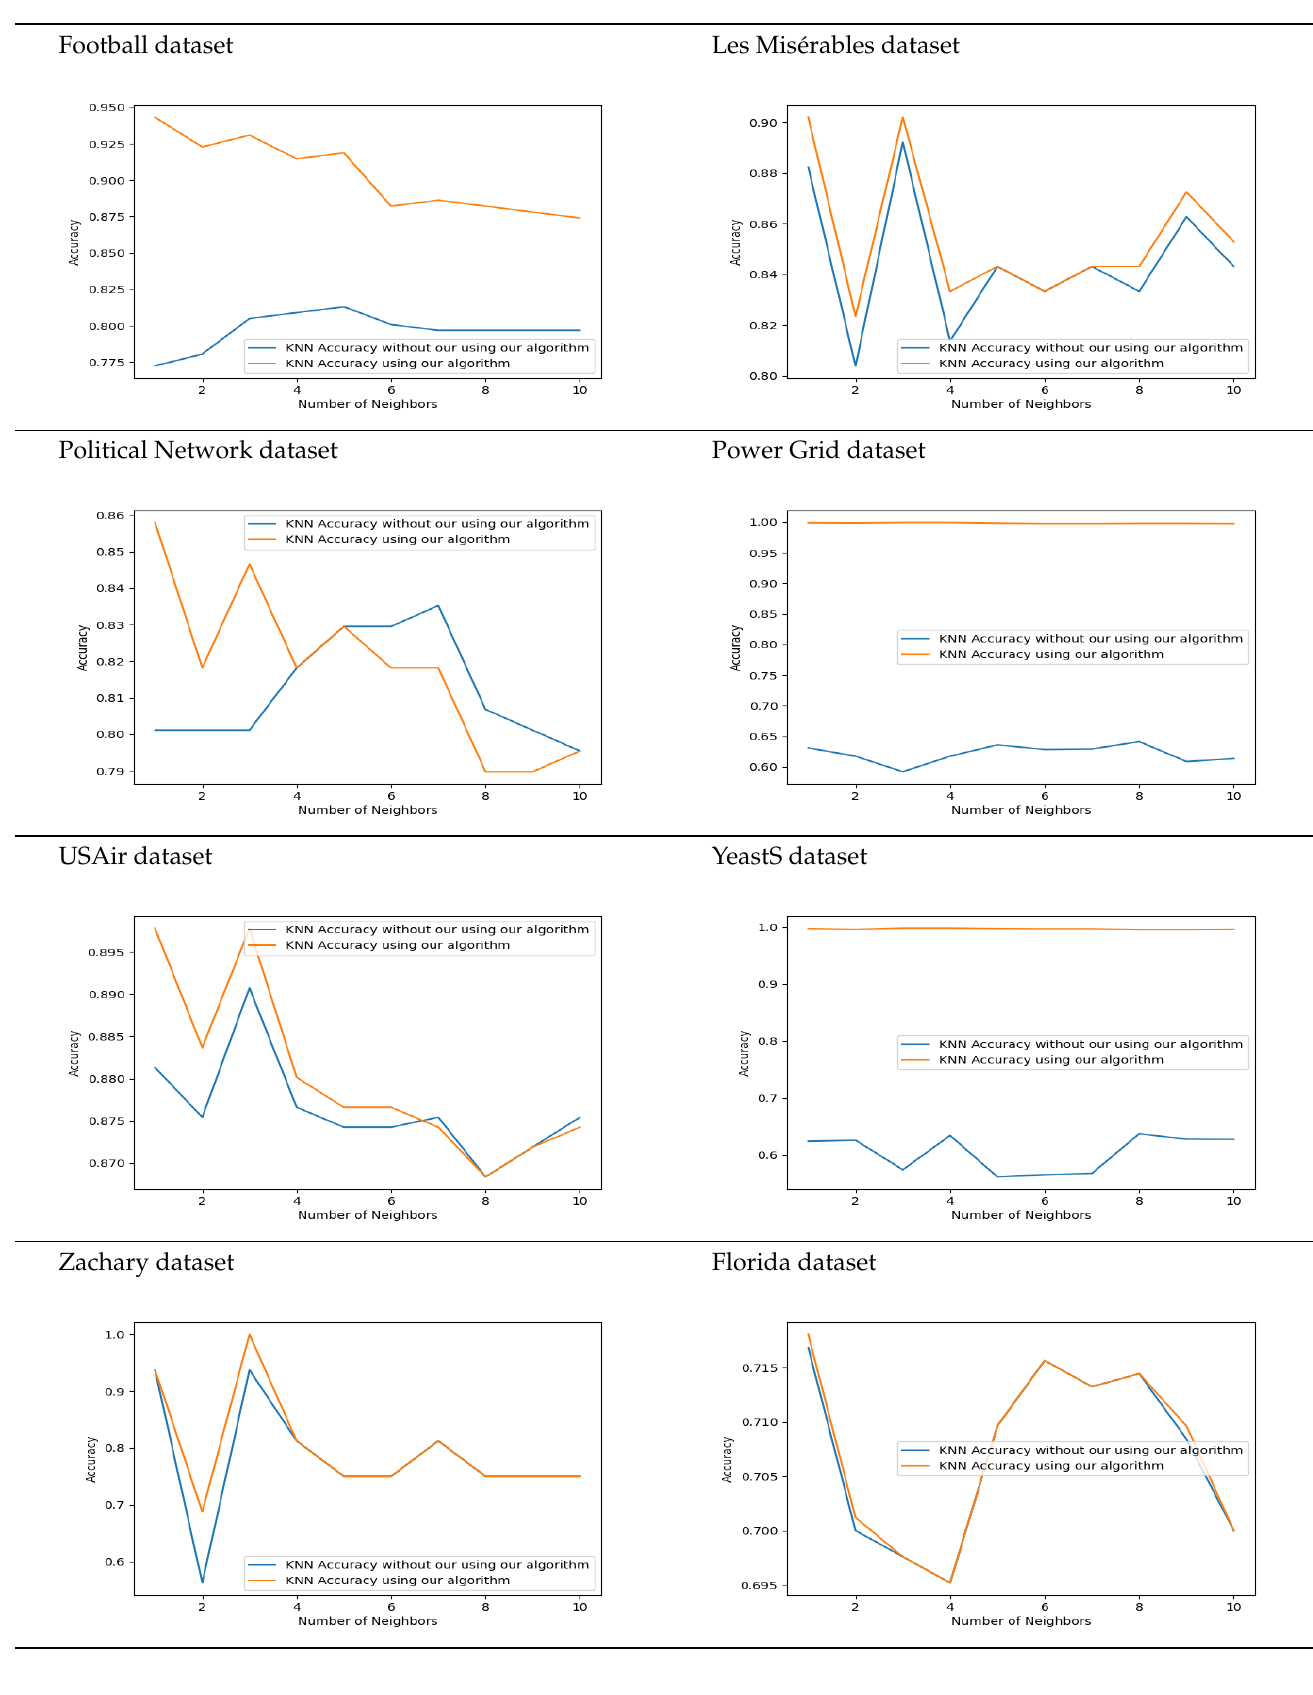
Table 6. The x axis represents the number of neighbors in the KNN model and the y axis is the